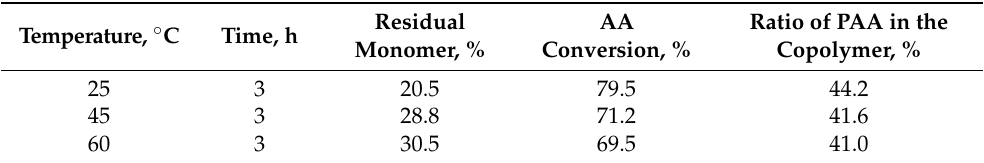
Table 3. Unreacted monomer and PAA content in collagen copolymers formed at different synthe- sis temperatures. Temperature, ◦